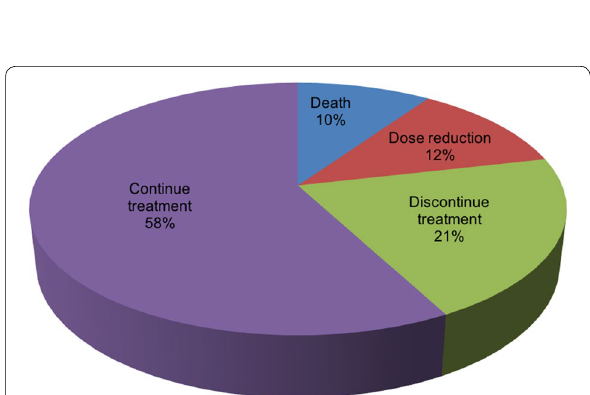
Fig. 3 The impact of adverse events on nintedanib treatment at the end of the monitoring period